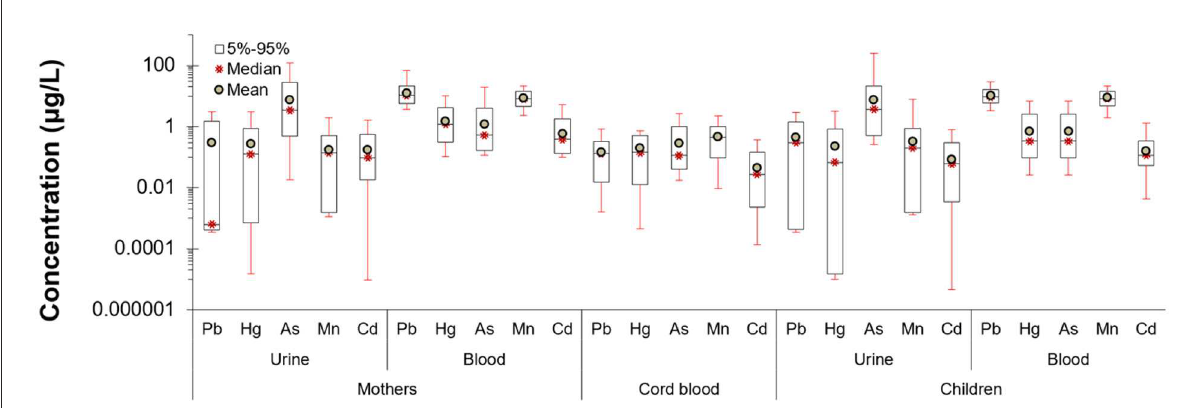
FIGURE1 Pregnancy and early life biomonitored levels of heavy metals in blood and urine of PHIME cohort participants ( n = 160). Mean concentrations of metals are below 1 µ g/L, except for arsenic, where the concentration levels are the higher among the rest of the metals. Lead had the higher concentration in blood samples, which is expected given that lead is a compound that